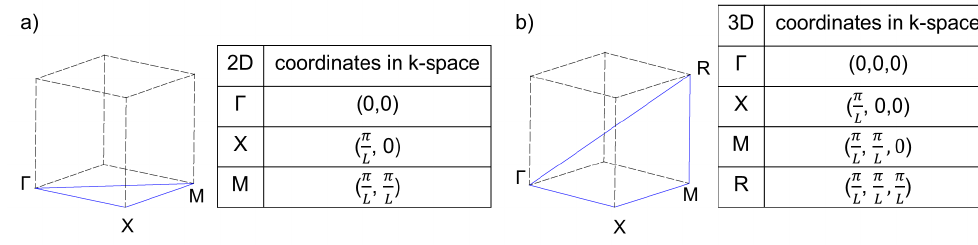
Figure 1. Two- ( a ); and three-dimensional ( b ) irreducible 1st Brillouin zone and corresponding coordinates of the path endpoints in (cid:126) k